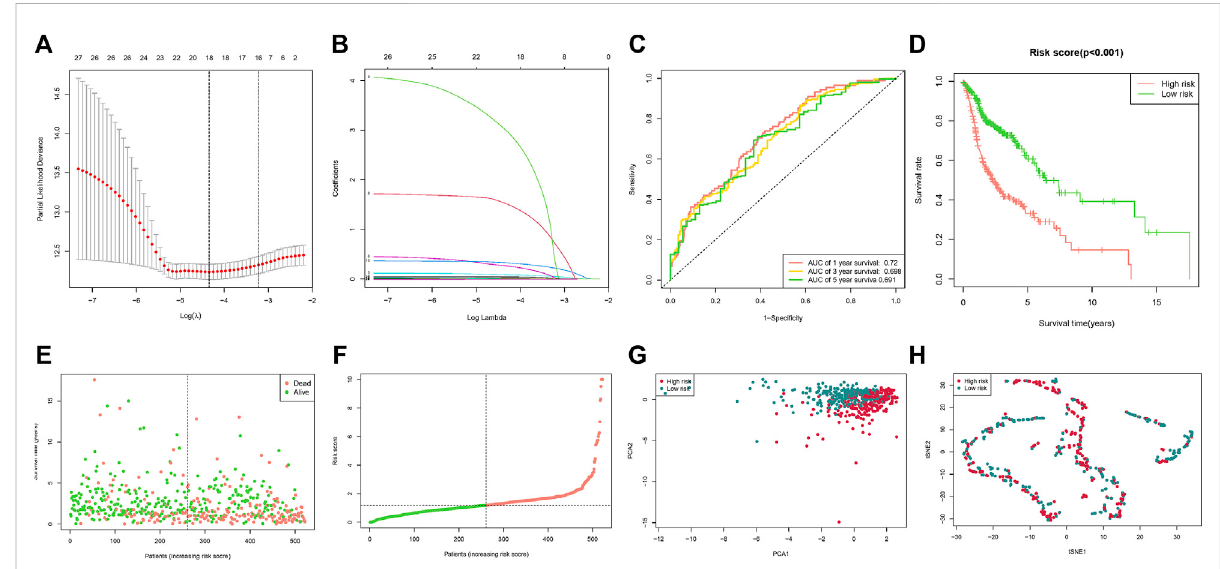
FIGURE 2 Risk score based on fatty acid metabolism-related microRNAs. (A) LASSO analysis with 10-fold cross-validation identi fi ed fatty acid metabolism-related microRNAs. (B) Coef fi cient pro fi le plots of fatty acid metabolism-related microRNAs. (C) The ROC curves of the low-risk and high-risk groups of the risk score. (D) Survival curves of the low-risk and high-risk groups of the risk score. (E) Risk score of the HNSCC patients. (F) Survivalcomparisonofthelow-riskandhigh-riskgroupsinHNSCC patients. (G) PCAplotofthelow-riskandhigh-riskgroups. (H) t-SNEplotof the low-risk and the high-risk